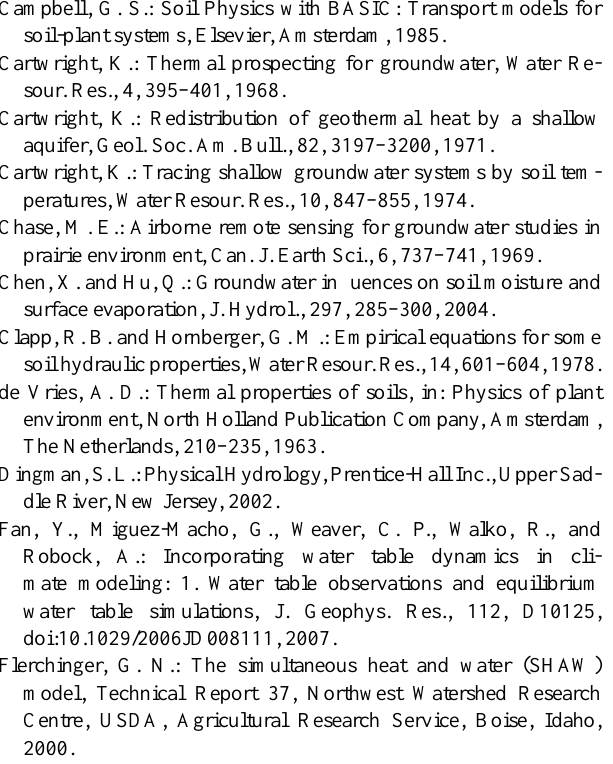
mate modeling: 1. Water table observations and equilibrium water table simulations, J. Geophys. Res., 112,